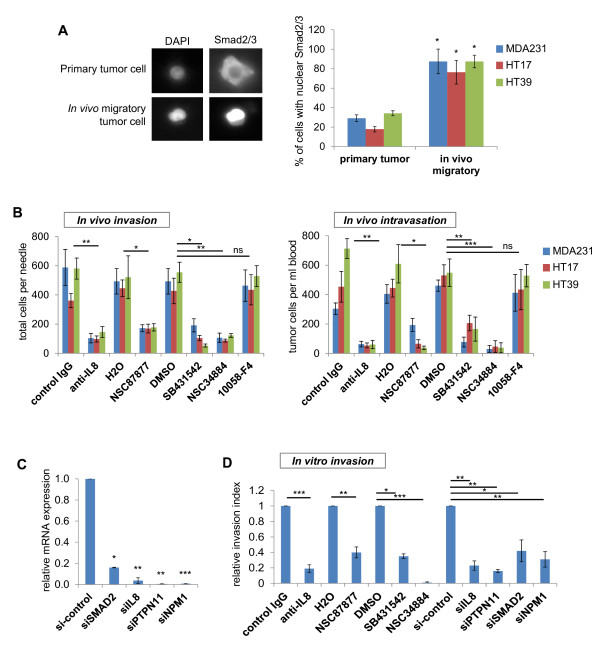
Functional validation of specific targets from the HIS in human breast tumors in vivo. (A) Migratory and average primary tumor cells were isolated in vivo from MDA-MB-231 as well as the patient-derived HT17 and HT39 tumors. Cells were fixed immediately after collection and immunostained for total Smad2/3 complex, with DAPI used as a nuclear counterstain. A representative image for a cell with cytoplasmic Smad2/3 staining from the primary tumor samples and a cell with nuclear accumulation of Smad2/3 from the migratory cell samples is shown. Quantification of total results is shown in the graph, for which the average percentage of cells with nuclear Smad2/3 accumulation over total number of cells (by DAPI count) was calculated for each xenograft. Error bars: SEM, *P < 0.05 (Student t test), n = 10 to 50 cells per sample; samples from at least three different mice. (B) In vivo invasion and intravasation were measured in mice bearing either orthotopic MDA-MB-231-GFP tumors (MDA231) or patient-derived HT17 and HT19 tumors, shortly after treatment with specific inhibitors or blocking antibodies. In vivo invasion is plotted as average number of migratory cells collected per microneedle. Intravasation is plotted as average number of circulating tumor cells per milliliter of blood. Results are shown for mice that received treatment with either vehicle control or specific inhibitor: neutralizing antibody specific to human IL8, PTPN11 specific inhibitor NSC87877, TGF-β receptor-specific inhibitor SB431542, NPM1-specific inhibitor NSC34884, or MYC-specific inhibitor 10058-F4 (negative control). Bars, average number of cells; error bars: SEM, *P < 0.05; **P < 0.01; ***P < 0.001; ns, not significant (Student t test for each condition relative to its vehicle control); n ≥ 6 microneedles from at least four mice for the in vivo invasion assay; n ≥ 6 mice for the intravasation assay. (C) mRNA expression of MDA-MB-231 cells transfected with siRNA for genes SMAD2, IL8, PTPN11, NPM1. Shown is expression for each target gene by its respective siRNA relative to the nontargeting control siRNA (si-control). Error bars: SEM, *P < 0.05; **P < 0.01; ***P < 0.001 (Student t test); n = 3 separate experiments for each siRNA. (D) In vitro invasion over Matrigel-coated transwells was measured for MDA-MB-231 cells, either transfected with siRNA to the genes indicated or with specific inhibitors or blocking antibodies. Shown is the relative invasion for each condition toward the appropriate control. Error bars: SEM, *P < 0.05; **P < 0.01; ***P < 0.001 (Student t test); n = three separate experiments for each condition with duplicate transwells per experiment.